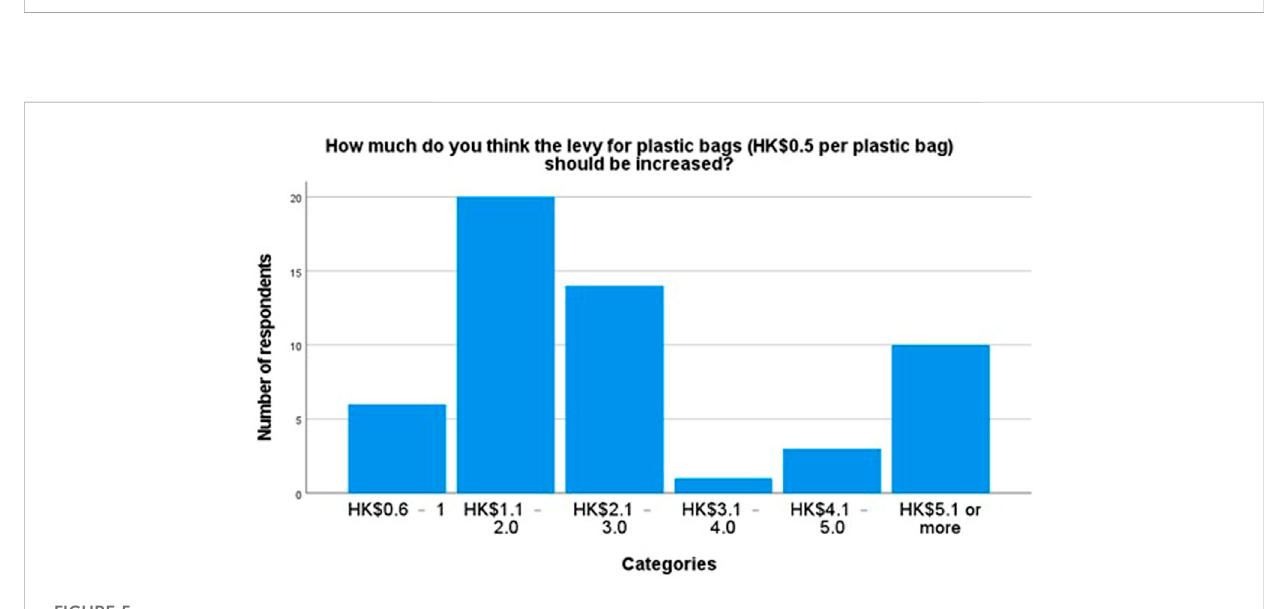
FIGURE 5 The charge of plastic bag levy that respondents want to